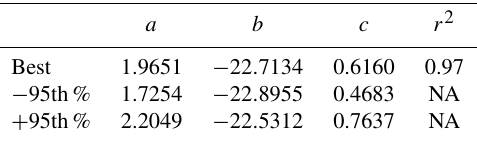
Table 1. Coefficients for the three-parameter Boltzmann fit of the SA water freezing background and values bound by the 95th- percentile confidence interval. a b c r